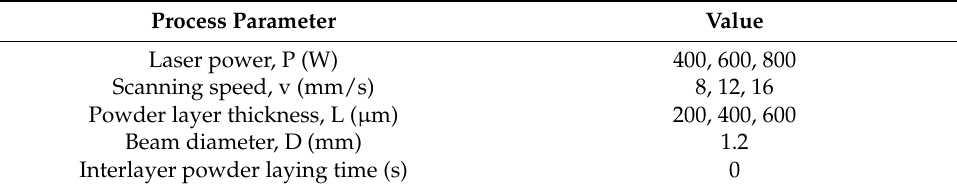
Table 3. Process parameters applied in this